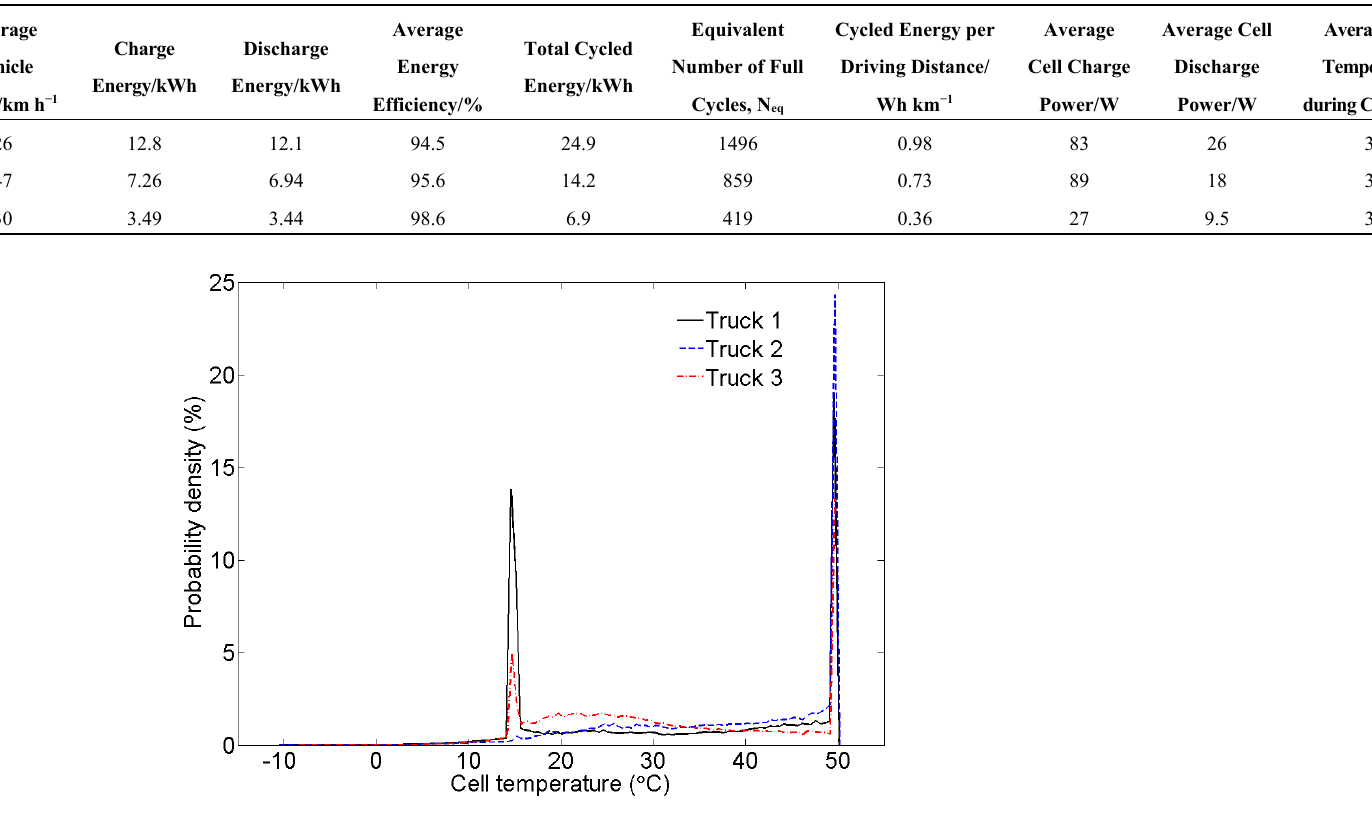
Table 1. Key figures from the driving pattern and battery usage analysis.